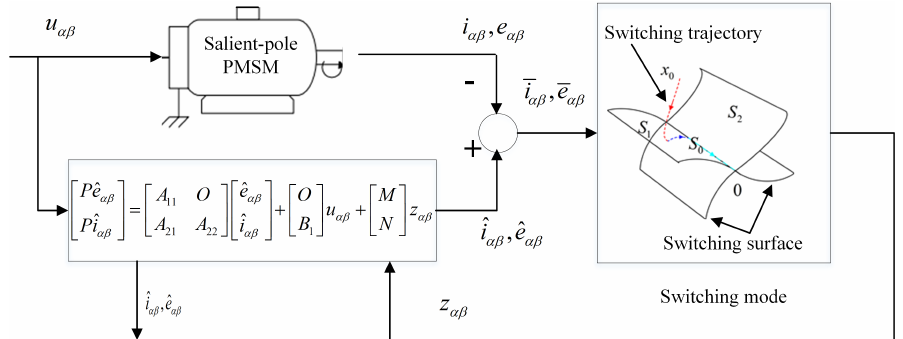
Figure 2. Sliding mode observer